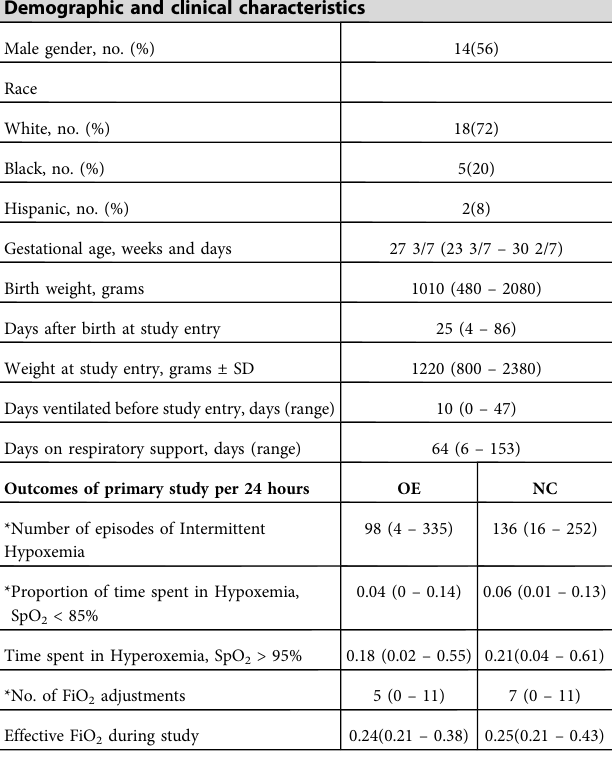
TABLE 1 Baseline and clinical characteristics of study participants (N =25) and outcomes by mode of oxygen supplementation. Demographic and clinical characteristics